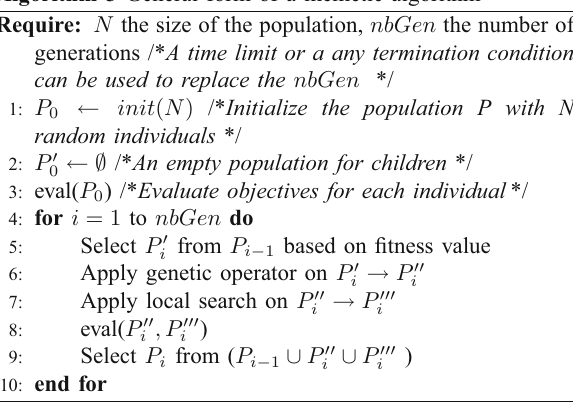
Algorithm 3 General form of a memetic